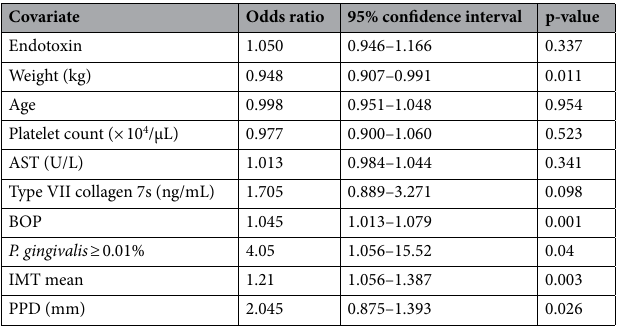
Table 4. Factors associated with NAFLD in advanced fibrosis. AST aspartate aminotransferase, BOP bleeding on probing, IMT intima-media thickness, NAFLD non-alcoholic fatty liver disease, PPD periodontal pocket depth.